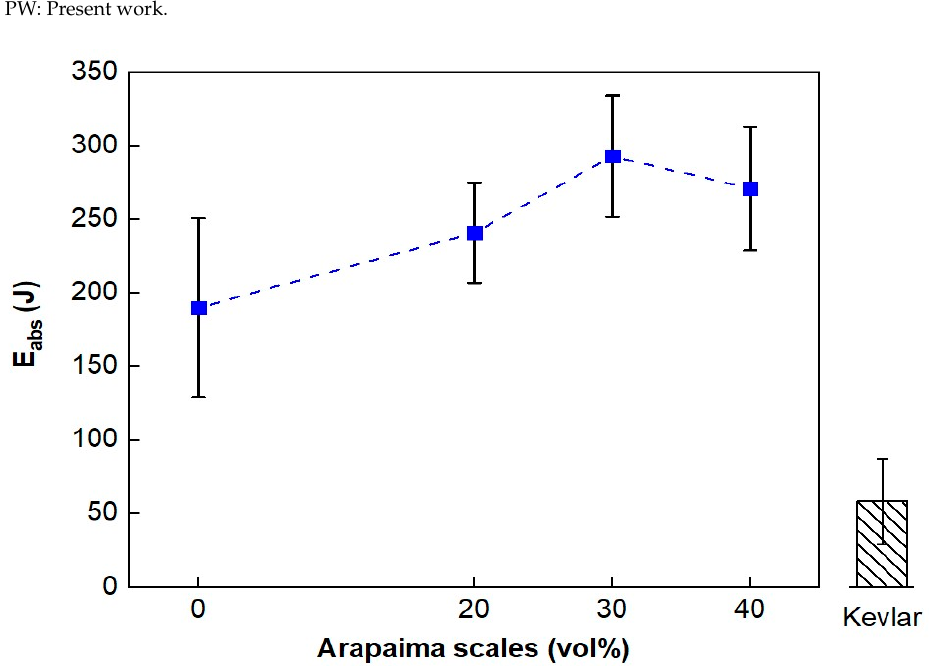
Figure 5. Average absorbed energy values of the composites reinforced with 20, 30, and 40 vol% of arapaima scales against 7.62 mm ammunition compared to those reported for